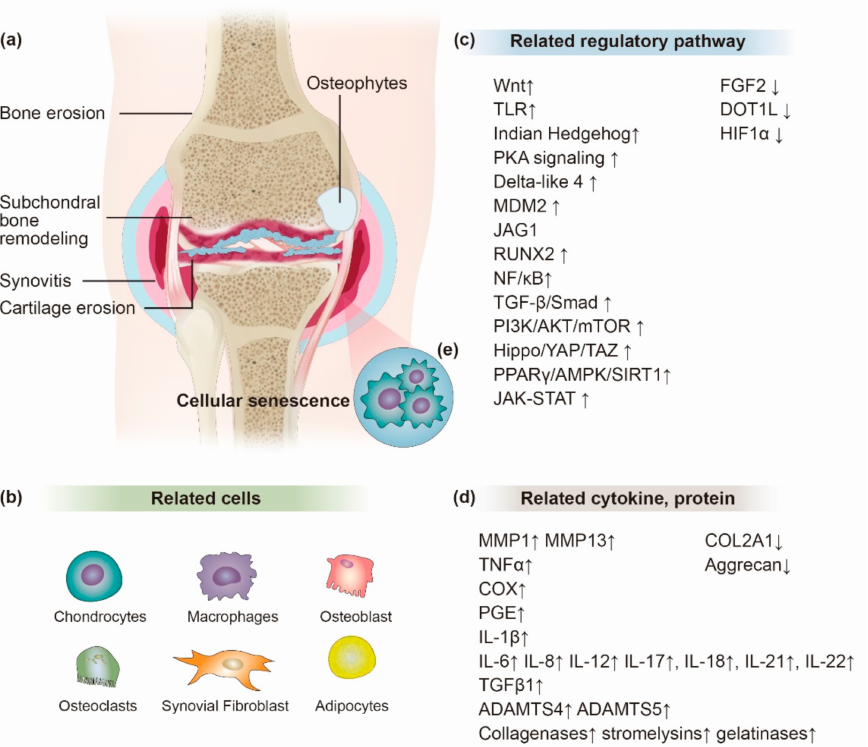
Figure 1. The “inflammatory” pathogenesis of osteoarthritis (OA). ( a ) OA is not only damage of cartilage, but also surrounding joint tissue including inflammation of the synovium, subchondral bone remodeling, bone erosion, and osteophyte formation were accompanied. ( b ) In addition, cells in the affected joint tissues actively participate in the OA initiation and progression. ( c ) Lots of regulatory pathways are related to OA onset and progression; however, not all are necessarily implicated in all phenotypes of the OA progression. ( d ) During OA progression, multiple inflam- matory cytokines and proteins are involved in damaging cartilage and promote an endless cycle of inflammation. ( e ) Senescent chondrocytes themselves also trigger an inflammatory response to the surrounding